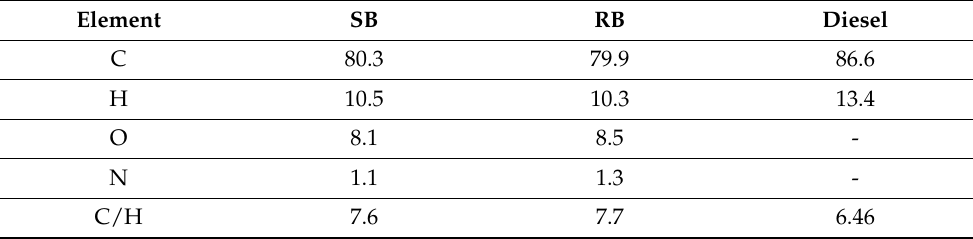
Figure 4. HHV of biodiesel obtained at various alcohol: oil molar ratio. ( A ) rapeseed biodiesel and ( B ) sunflower biodiesel. Data are reported as the average ± SD (n = 3). Table 2. Elemental analysis of SB (biodiesel from sunflower oil); RB (biodiesel from rapeseed oil) and diesel. Both were obtained using methanol. Measurements were performed in triplicate, and the average value is reported. S.D. less than 5% ( n =